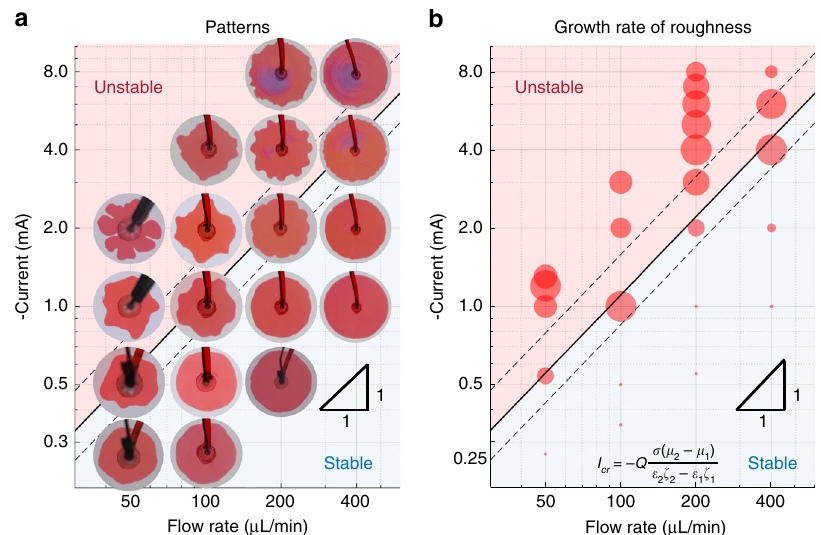
Fig. 4 Stability diagram at different fl ow rates and currents ( M = 1.98). a The patterns of the interfaces ( t = 90 s). Clear fi ngers can be seen beyond a critical current for each fl ow rate. b Growth rate of the interfacial roughness. The growth rates of the interfacial roughness at different conditions are plotted as circles. The theoretical critical current is given by the inset equation and plotted as the solid line ( ζ 2 = ζ w = − 150 mV, ζ 1 = ζ o = 0 mV). Dashed lines are theory predictions with ±30% variation in ζ w . The predicted stable/unstable regions are shaded blue/red. The videos of the evolution of